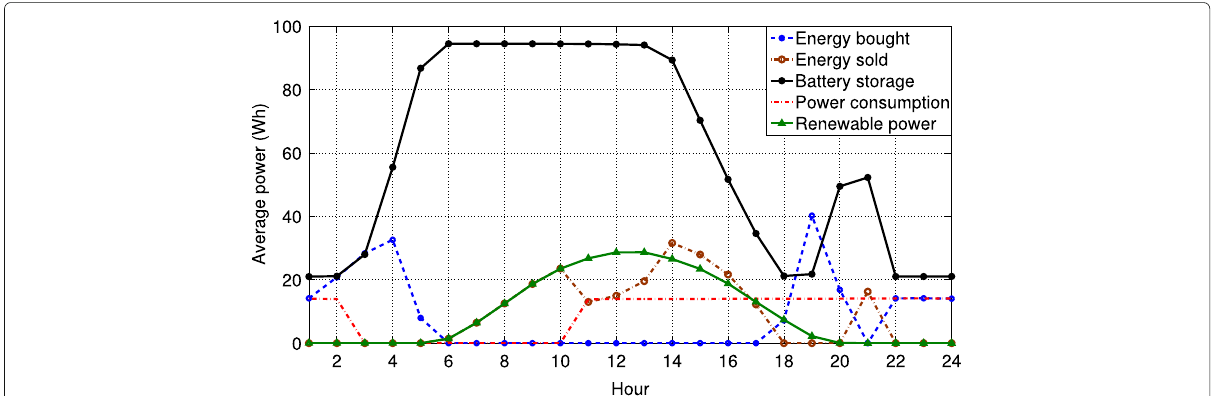
Fig. 6 Energy transaction, consumption, production, and storage with the ideal strategy under C 2 , averaged over 5 years